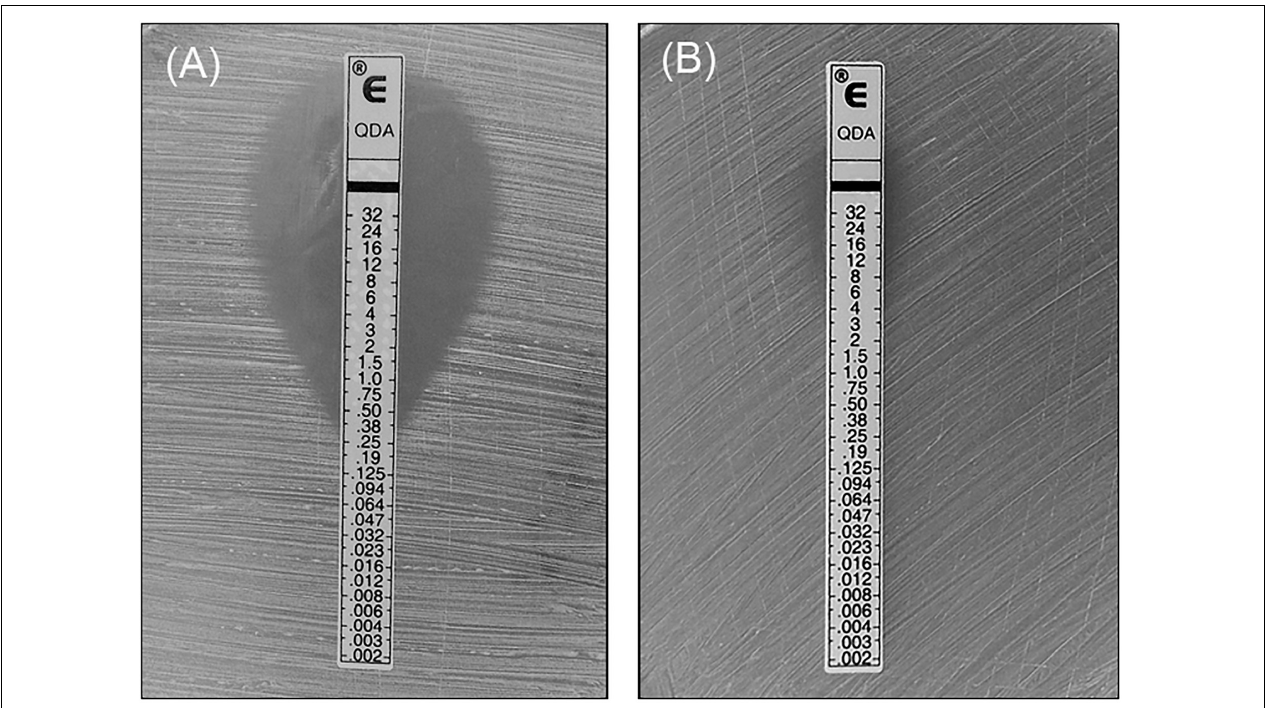
FIGURE 1 | The MIC value of QDA against the recipient strain and the transconjugant strain. (A) Recipient strain, R3645; (B) Transconjugant strain, N7435/R3645.